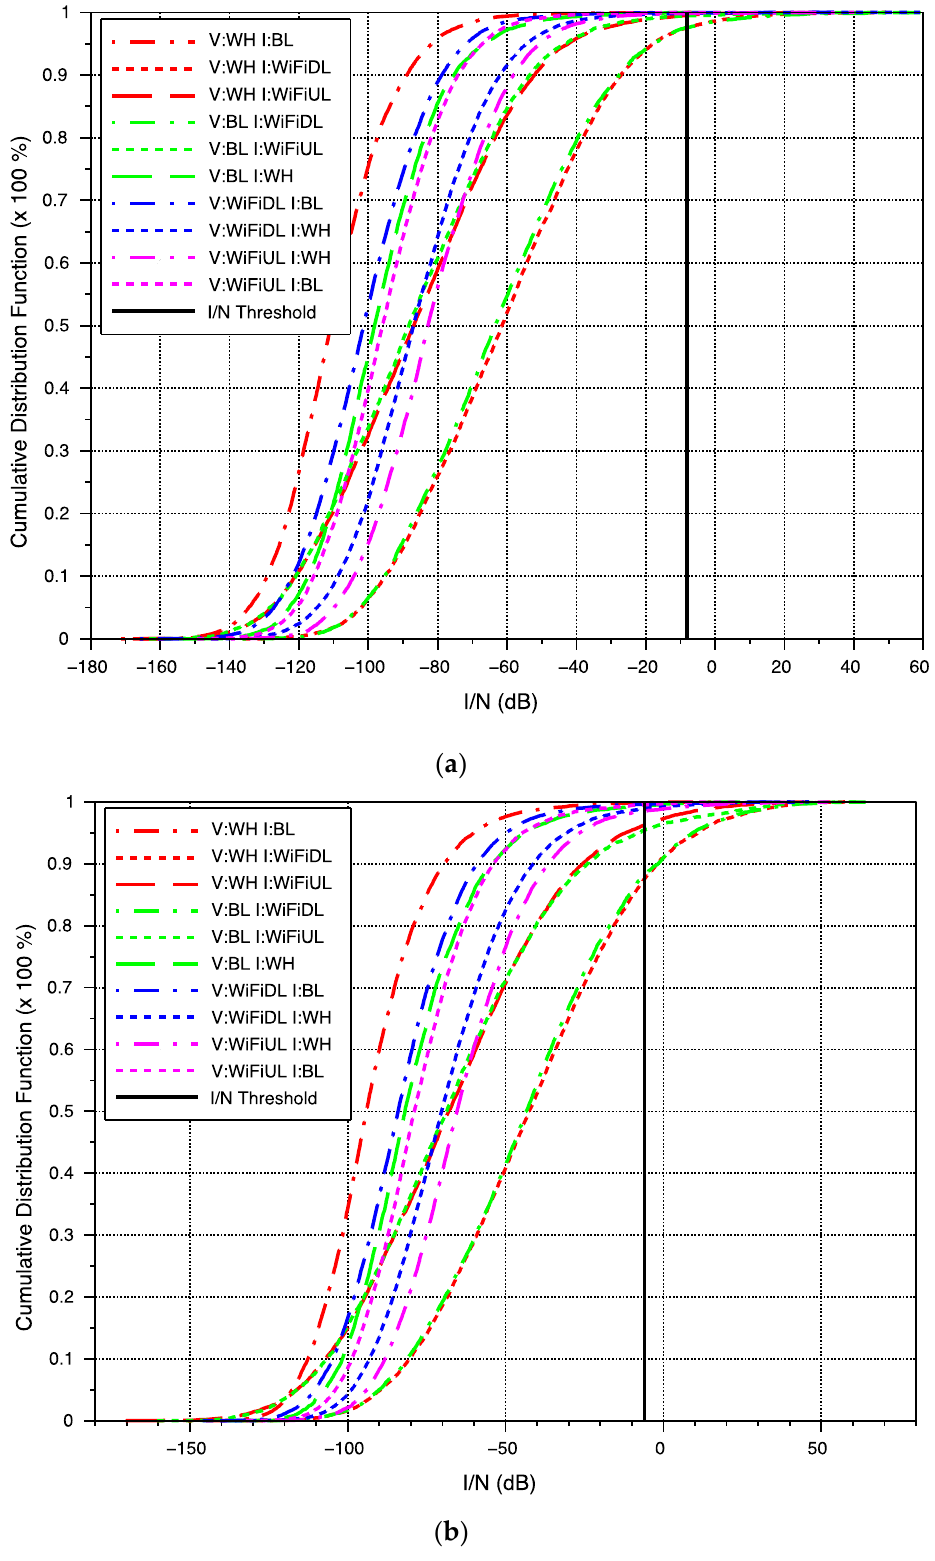
Figure 9. CDF for all scenarios as a function of I / N : ( a ) 100 interfering transmitters/ha; and ( b ) 1000 interfering transmitters/ha. The black vertical line represents the interference criterion ( I / N = −6 dB).